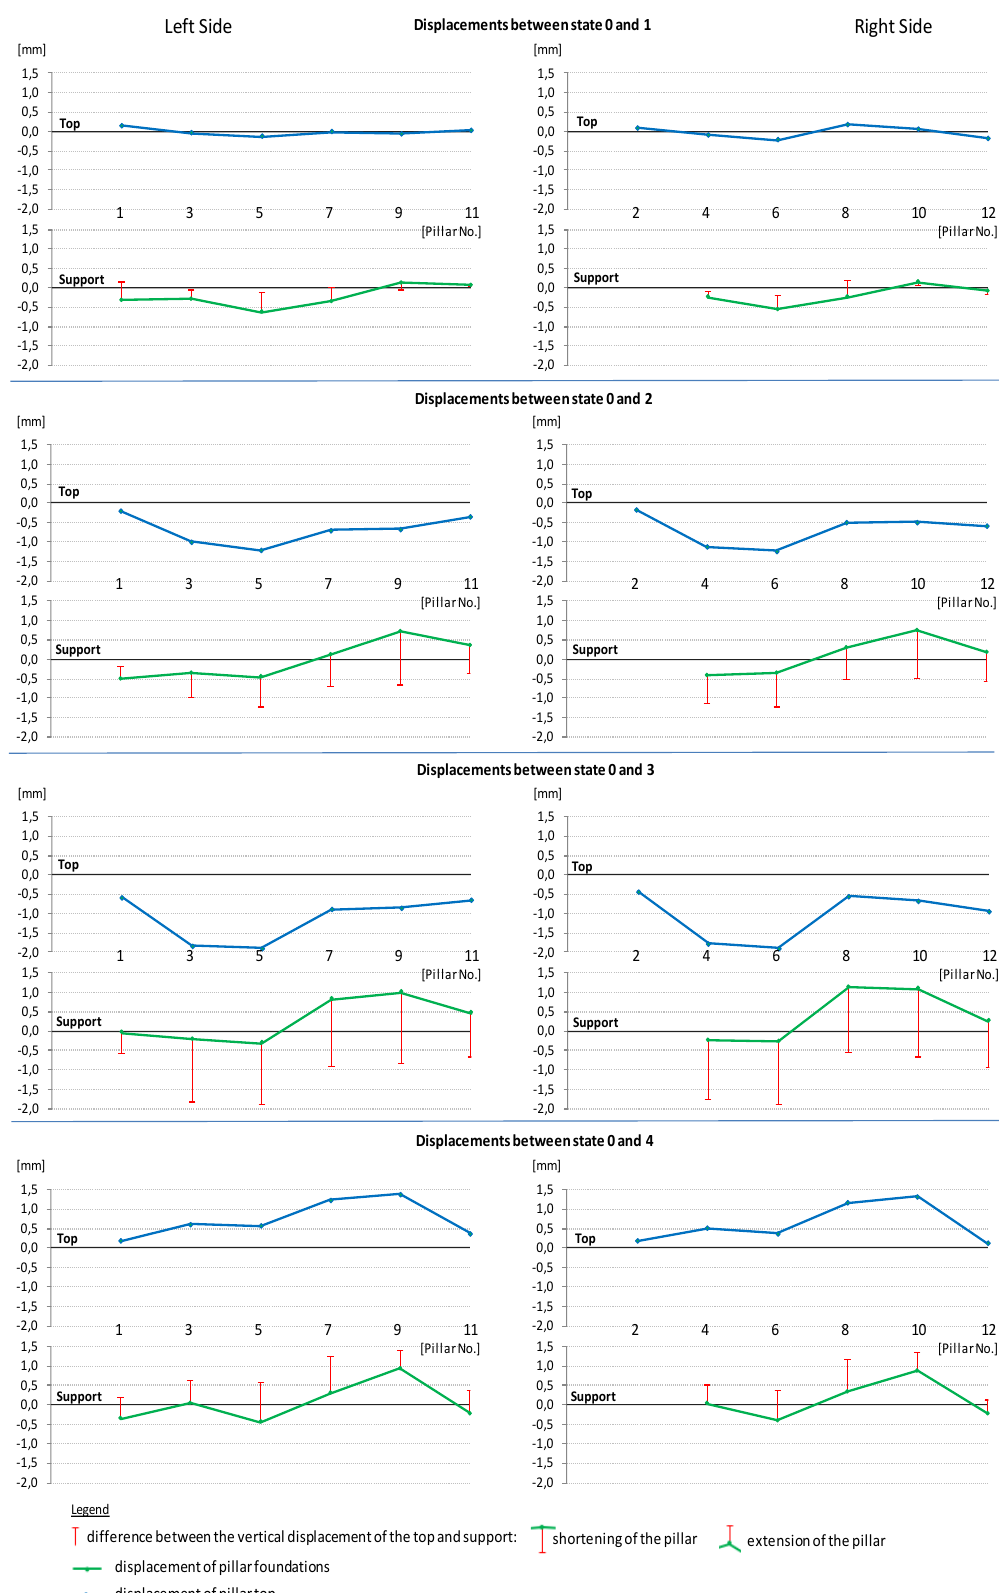
Figure 7. Vertical displacements of the control points.